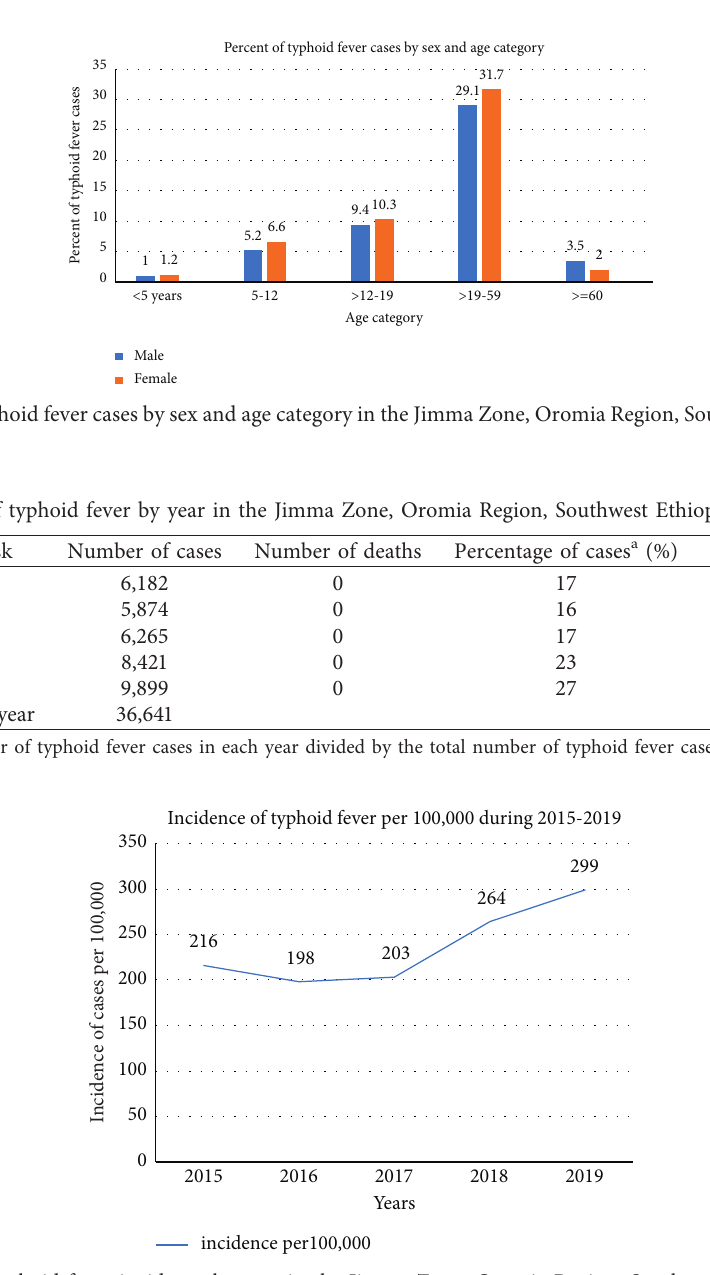
Figure 3: Distribution of typhoid fever incidence by year in the Jimma Zone, Oromia Region, Southwest Ethiopia, from